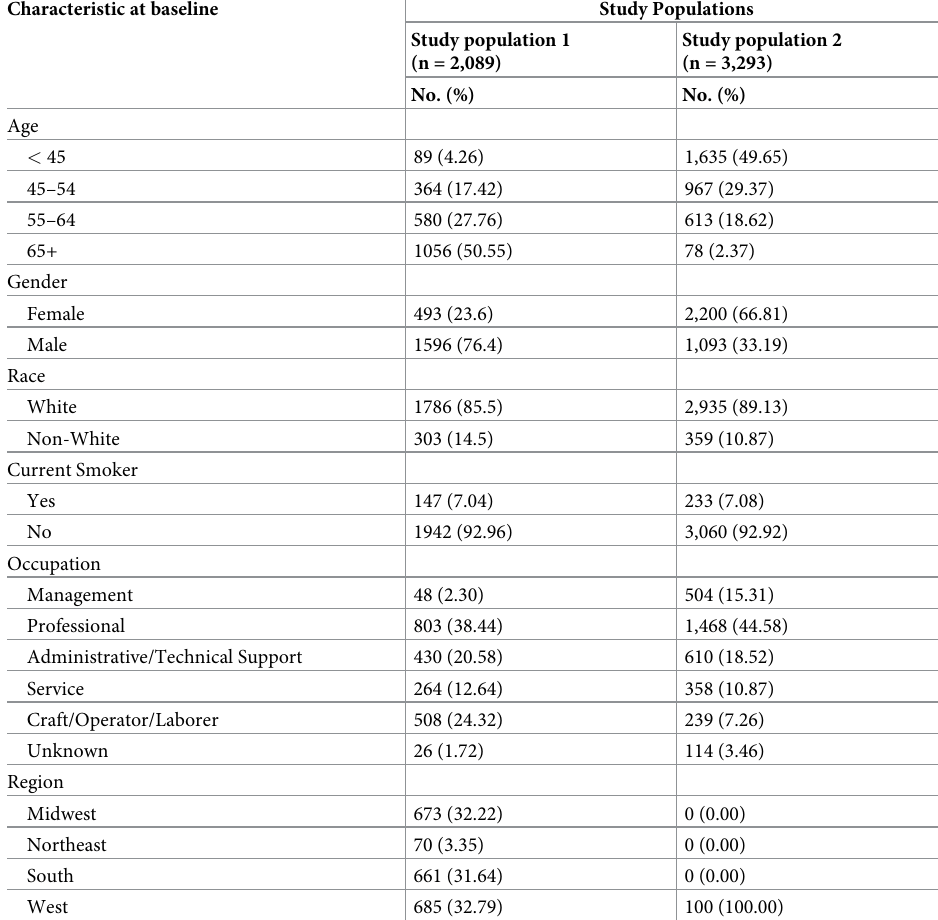
Table 2. Baseline demographic characteristics of study population 1 (US former DOE workers, 2005–2015) and study population 2 (Colorado workers from multiple businesses, 2010–2014). Characteristic at